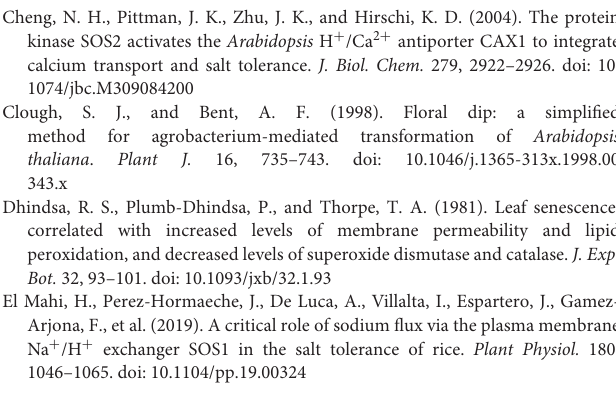
Supplementary Figure 1 | (A) Locations of cis-elements in the ThSOS gene promoters. (B) Descriptions of the cis-elements. Supplementary Table 1 | Classification of SOS genes in different